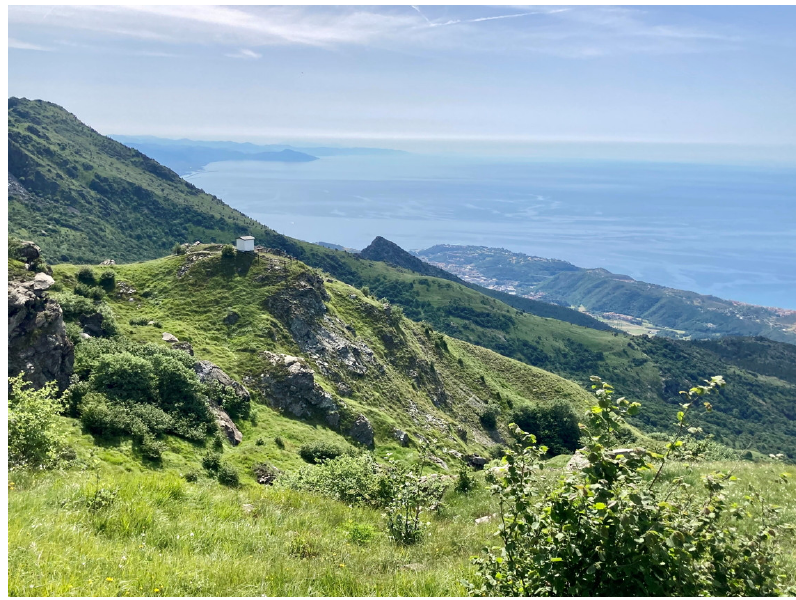
Figure 2. Panoramic view of the Tyrrhenian slopes from Pratorotondo (Mt Beigua). As for geologic features, Beigua UGGp is located at the junction between the Ligurian Alps (southeastern termination of the Italian Western Alps) and the Northern Apennines and is characterized by outstanding and unique geodiversity resulting from the long and